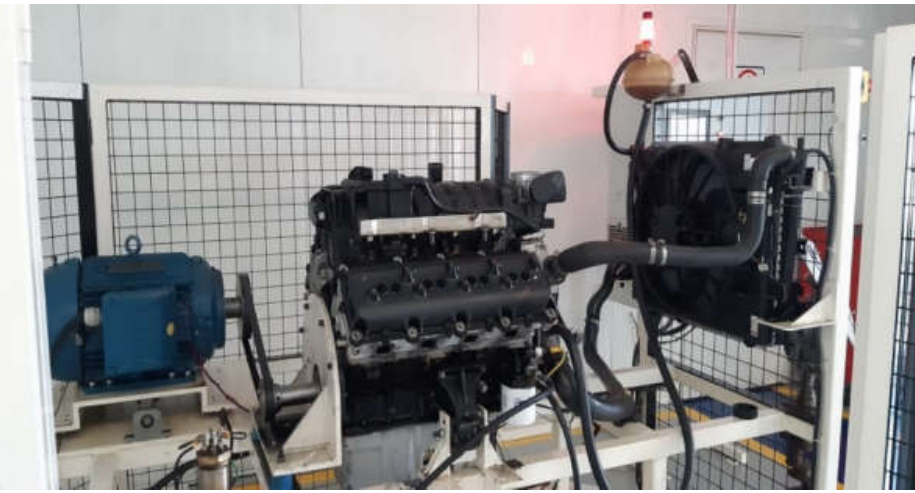
Figure 4. Electric Spin Rig machine—V8 engine 5.7L.